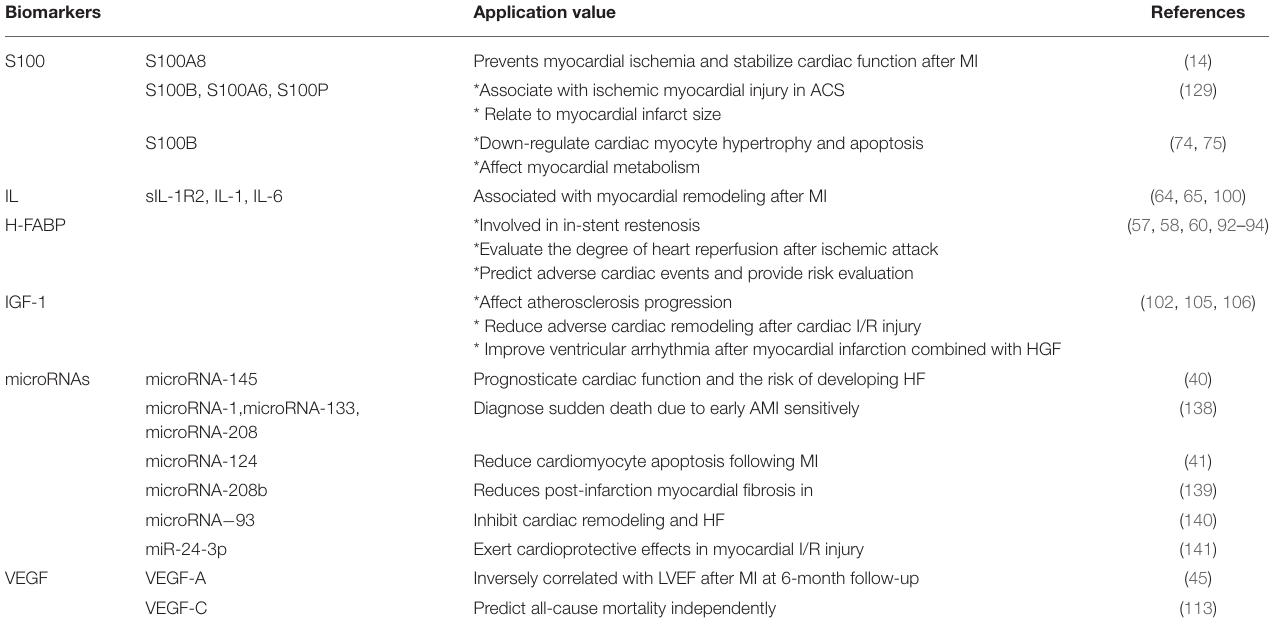
TABLE 5 | Other biological functions of MI circulating